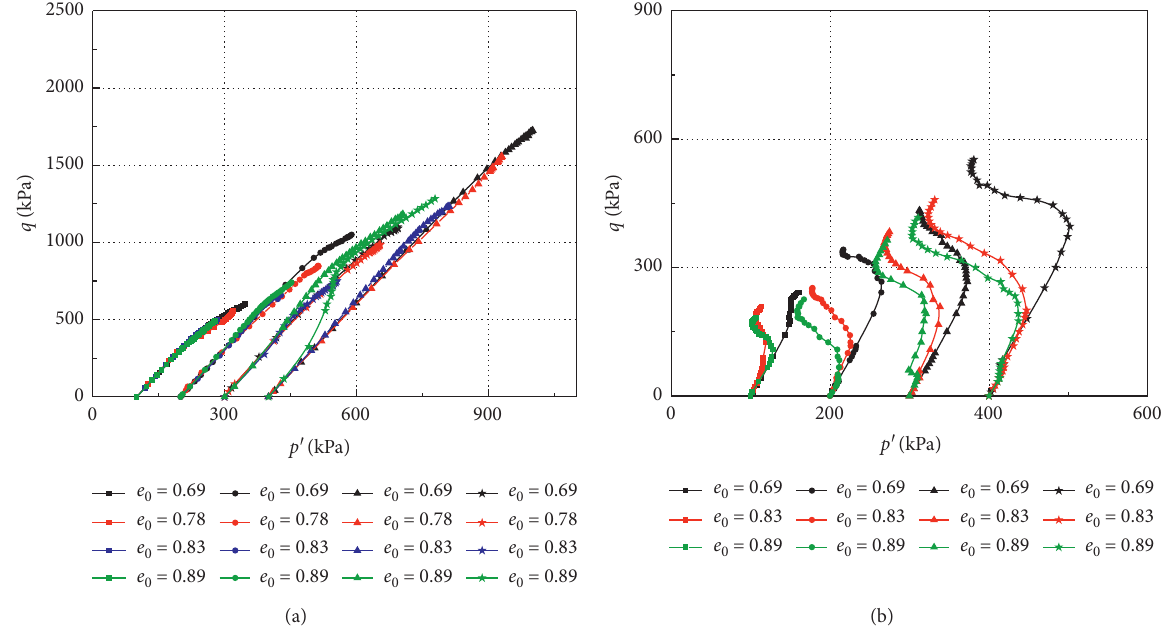
Figure 11: Effective stress paths with different initial void ratios: (a) coral mud and (b) Taizhou